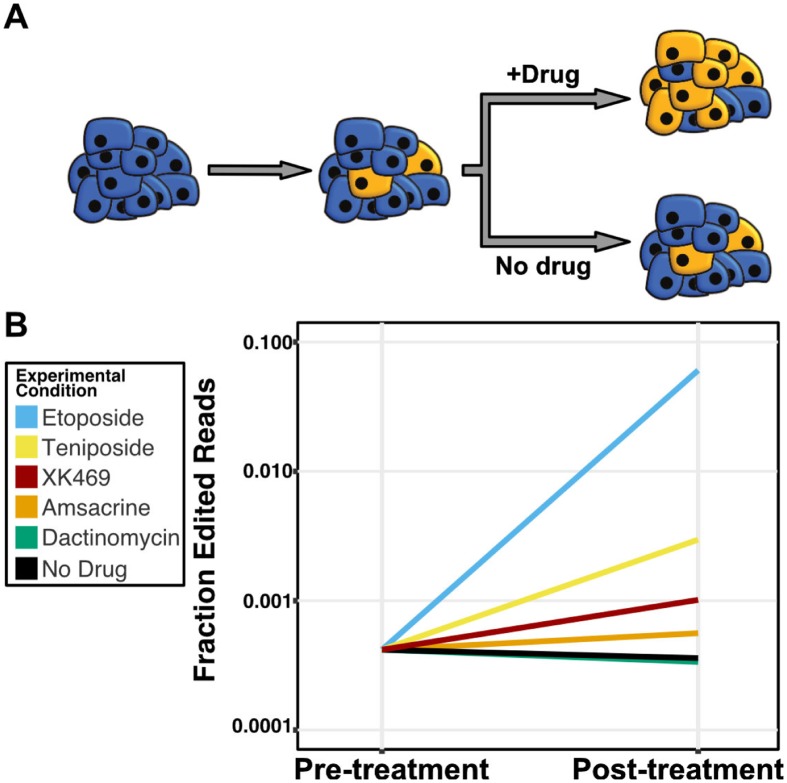
Human cells that contain hTOPOIIα M762Q are more resistant to etoposide, teniposide, and XK469.(A) Cartoon depiction of human cell-line experiment. A population of cells is incubated with CRISPR reagents to introduce the M762Q mutation in hTOPOIIα. A small fraction of cells are edited at this position and depicted in orange. Prior to splitting this population of cells into separate growth cultures with drug or control conditions, a subset of cells are prepared for sequencing to assess the fraction of edited cells. Split populations are then allowed to grow for two weeks and prepared for sequencing. In this example, blue cells contain the wt hTOPOIIα and the orange cells contain the edited M762Q hTOPOIIα, both strains contain the wt hTOPOIIβ. (B) Log-transformed fraction of sequencing reads that contain the CRISPR-edited allele of hTOPOIIα is plotted on the y axis for pre-treatment and post-treatment cell populations. The fraction of cells that contain the hTOPOIIα glutamine allele increase by 168.2-, 8.2-, 2.8-, and 1.6-fold upon treatment with etoposide, teniposide, XK469, and amsacrine, respectively, when compared to the no-drug control. All four of these enrichments of the edited glutamine allele were significant by Fisher’s exact test (etoposide and teniposide, p-value < 2.2E-16; amsacrine p-value = 0.025; XK469 p-value < 1.67E-13). The fraction of cells that contain the hTOPOIIα glutamine allele did not significantly increase in dactinomycin treated cells (Fisher’s exact test, p-value = 0.7182).